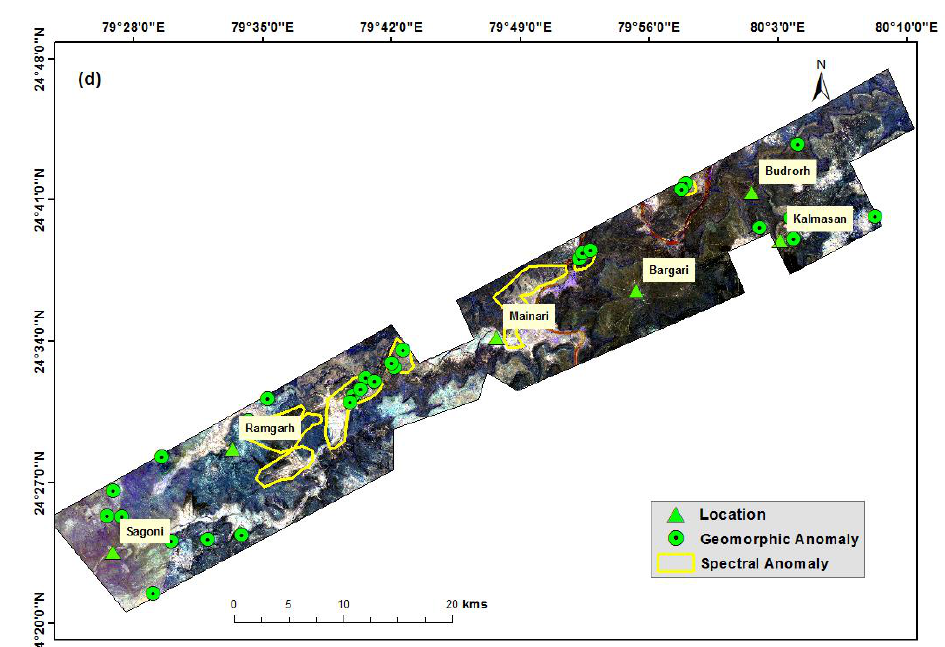
Figure 3. Geological evidences used for deriving the potential zones .a. Lineament( only lineament greater than 5km length were used to derive lineament buffer map. b. Lineament density. C alteration map (ASTER data were available for 80% of the study area)d.Points of geomorphic anomaly are draped above the